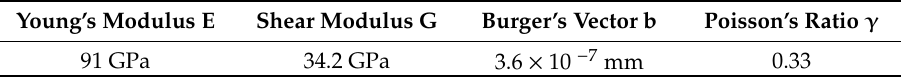
Table 1. Physical property parameters of CuZn20